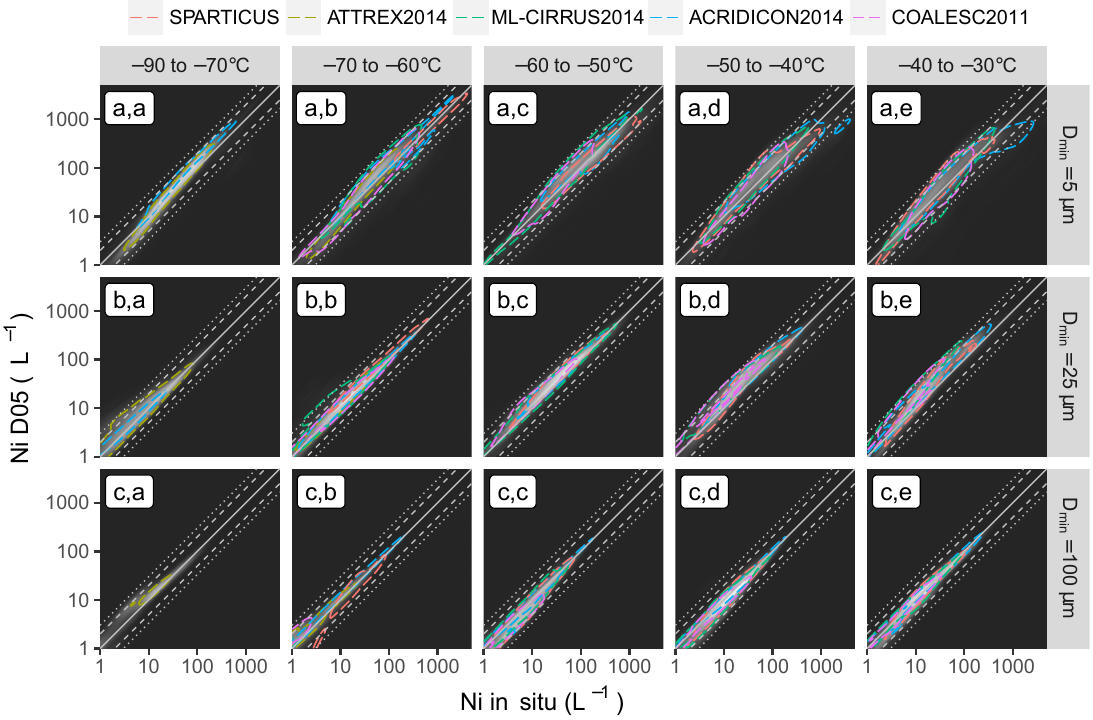
Figure 2. Density scatterplot showing N i theoretically estimated by D05 as function of corresponding in situ measurements (from white to black indicates high to low frequency of occurrence). Colored isolines indicate the 68% (one standard deviation) confidence interval for each campaign. Density and confidence intervals are provided per 10 ◦ C temperature bin from − 80 to − 30 ◦ C (first to fifth column) as is the lower integration threshold for N i (5, 25 and 100µm in the first, second and third row, respectively). The identity line and a factor of 2 and 3 around the identity line are indicated by grey plain, dashed and dotted lines,